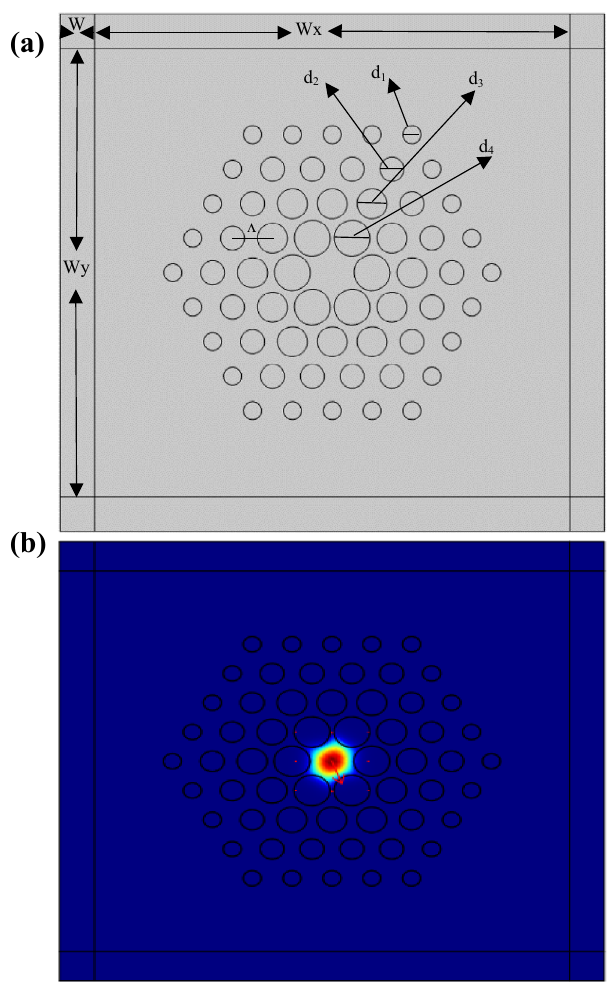
Fig. 1 a The cross-section of the descending hole arrangement, PCF1. b Fundamental mode profile at 1.55 µm of x -polarisation mode